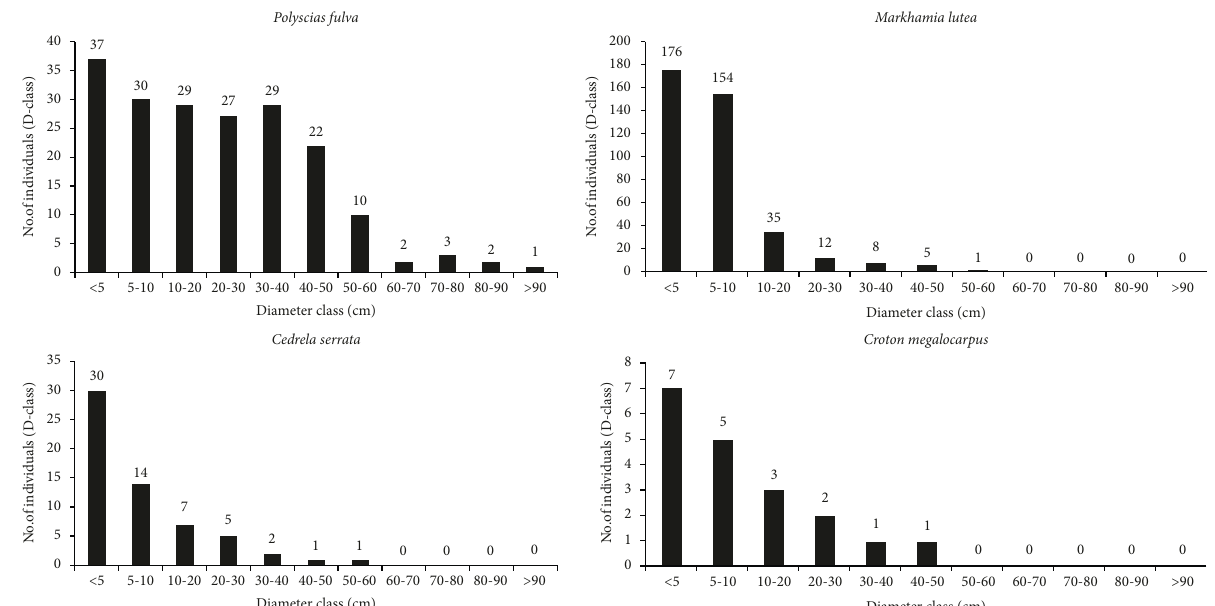
Figure 8: Size class distribution of individual trees in four of the tree species observed in the self-regenerated secondary forest in Ruhande Arboretum, Huye, Rwanda.